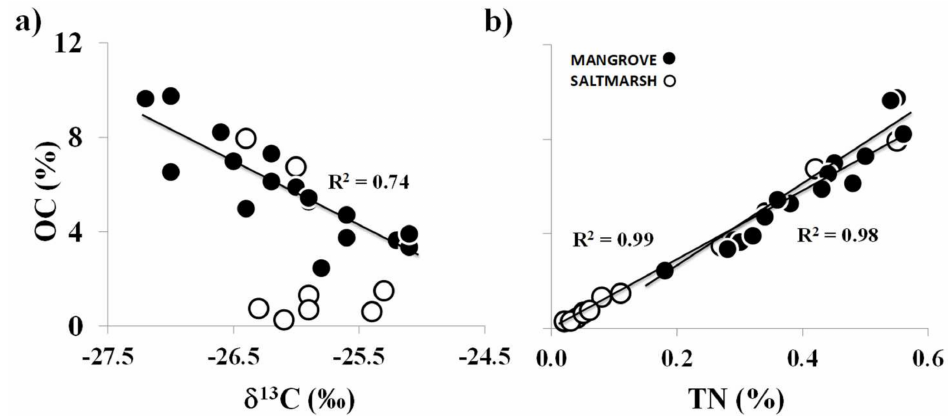
Figure 4. ( a ) Relation between organic carbon (OC) vs. δ 13 C. ( b ) Relation between organic carbon (OC) vs. total nitrogen (TN) for mangrove and saltmarsh